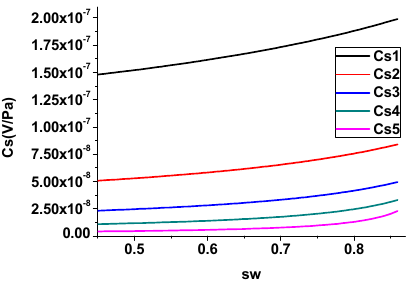
Figure 10. Influence of pore size on streaming potential coupling coefficient (slug flow). Figure 11 investigates the effect of fluid salinity on the streaming potential coupling coefficient of the capillary in the slug flow case. The salinity is taken as 0.015 mol/L, 0.03 mol/L, 0.045 mol/L, 0.06 mol/L, and 0.075 mol/L, respectively. It can be seen from the figure that the coupling coefficient gradually decreases with the increase in salinity. With the increase in pore fluid salinity, the shear potential of the electric double layer and the streaming current will decrease, so the coupling coefficient will decrease.